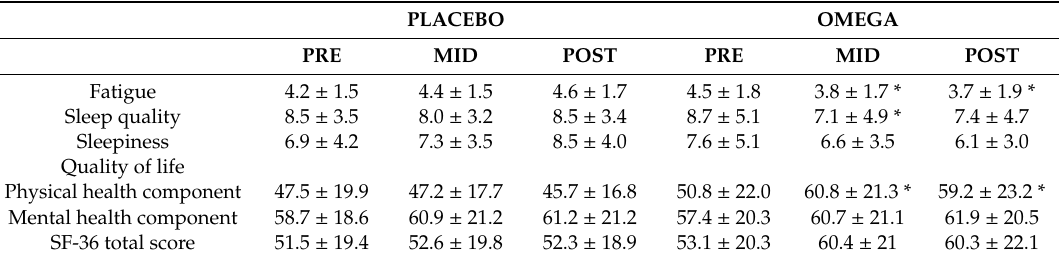
Table 5. Fatigue, sleep quality, sleepiness and quality of life at pre, mid (3mo) and post (6mo) of placebo or omega